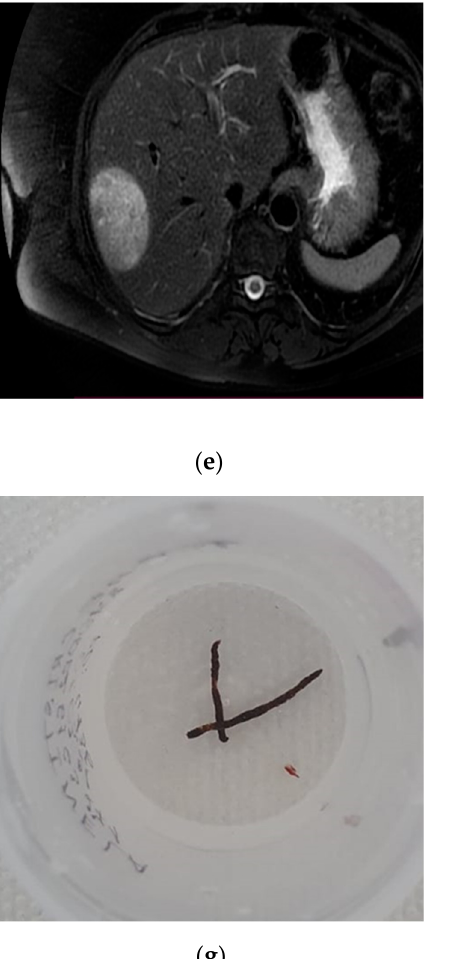
Table 5. LI-RADS-5 accuracy for HCC.